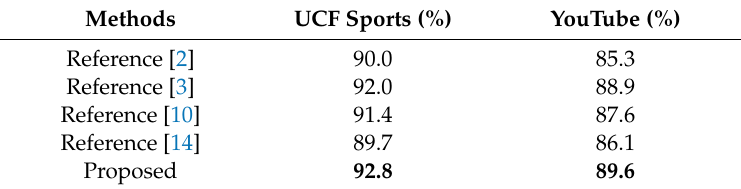
Table 2. Comparison of recognition accuracy with other similar algorithms.